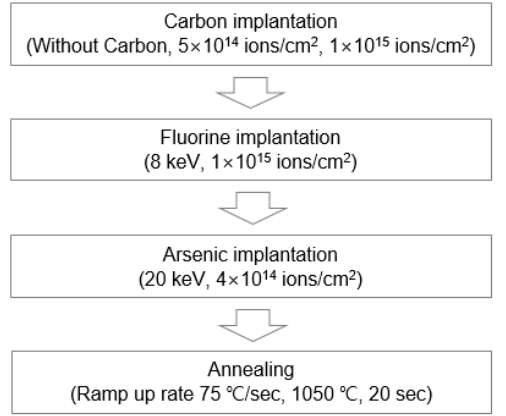
Figure 2. Flow chart of the overall process including implantation and annealing